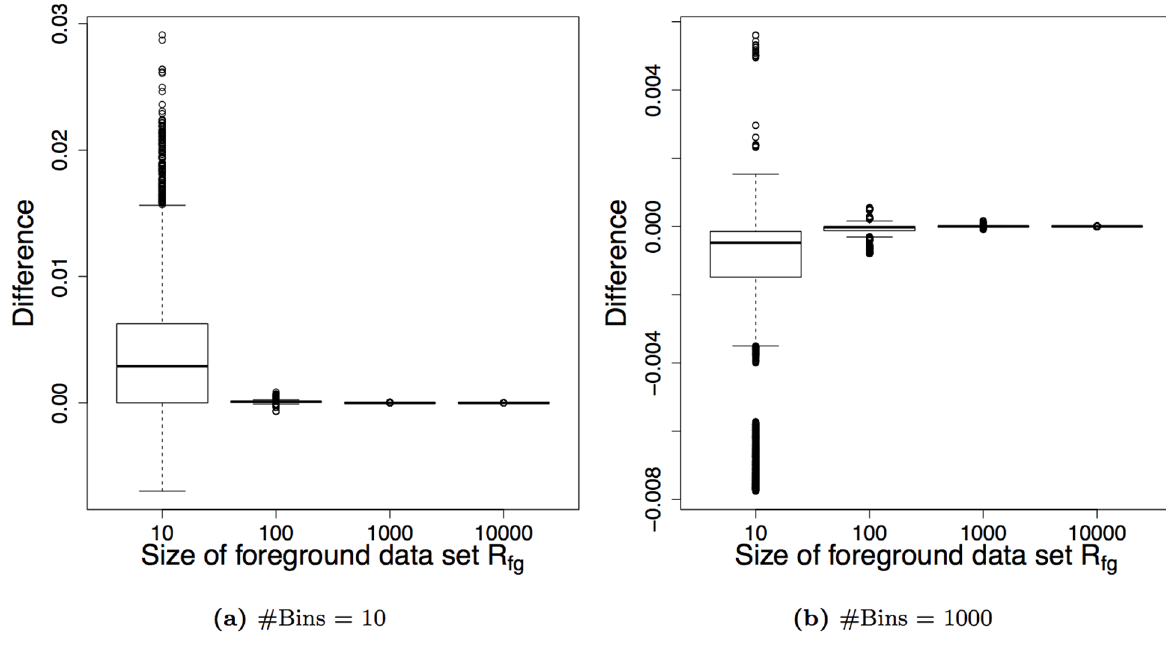
Figure 3. Differences of AUC-PR between the interpolations for varying size of the foreground data set. Panel (a) depicts the results for 10 bins equivalent to at most 10 different classification scores, whereas panel (b) depicts the results for 1,000 bins.